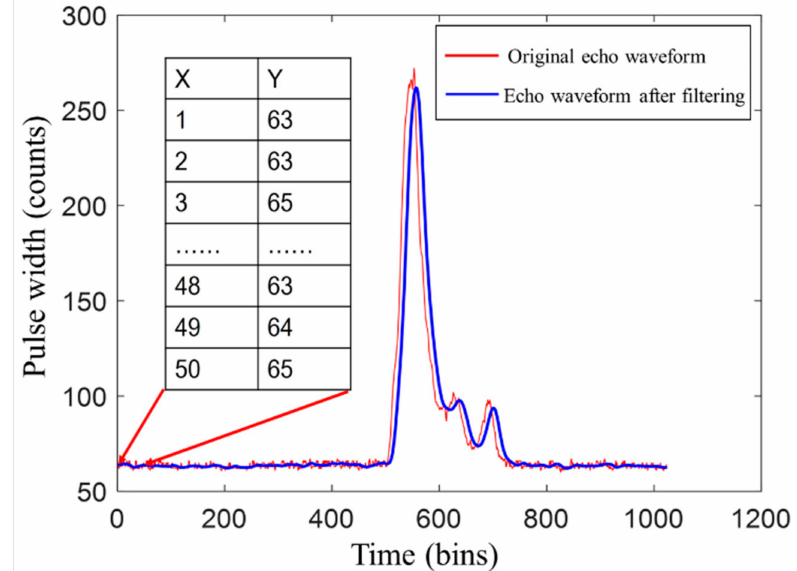
Figure 1. Comparison of LiDAR waveform and filtered